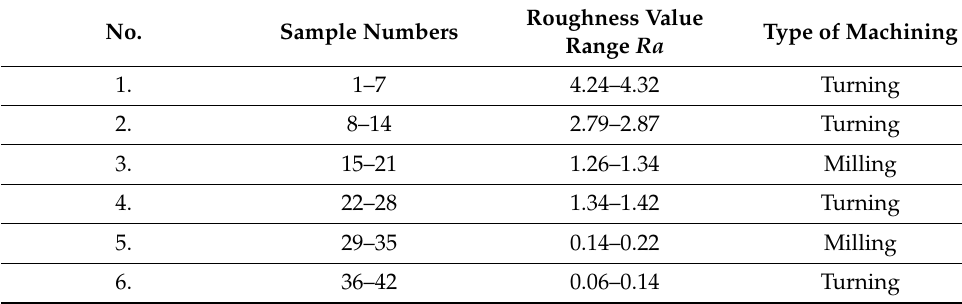
Table 3. Values of the Ra parameter for given surface groups.